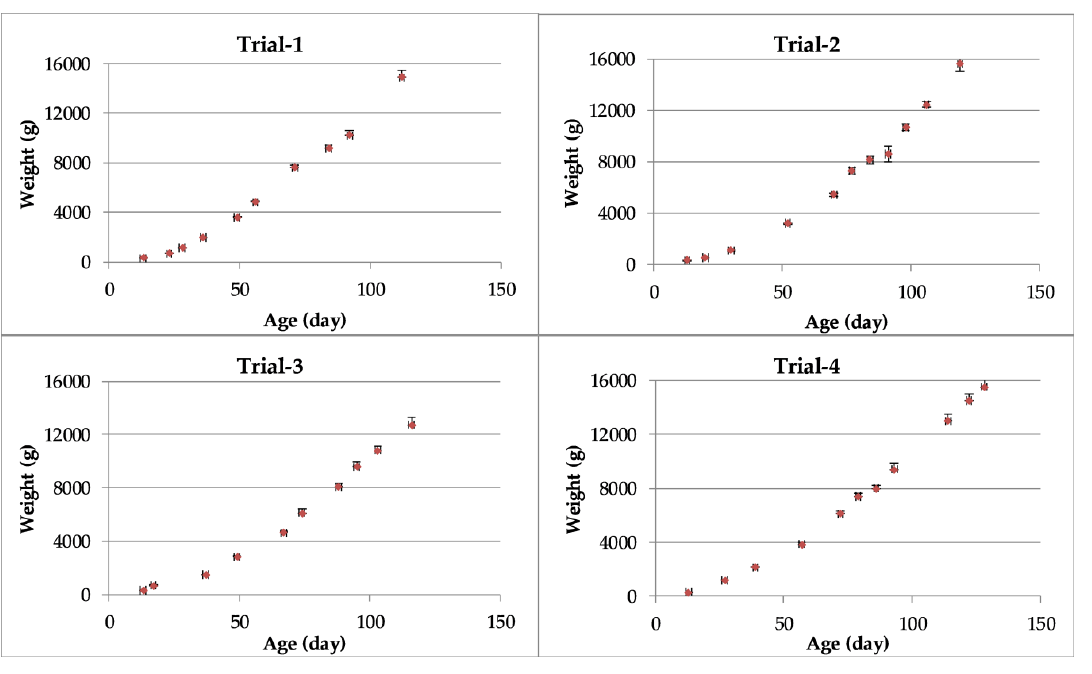
Figure 2. Means and standard error (bars) of turkey weights as a function of age.